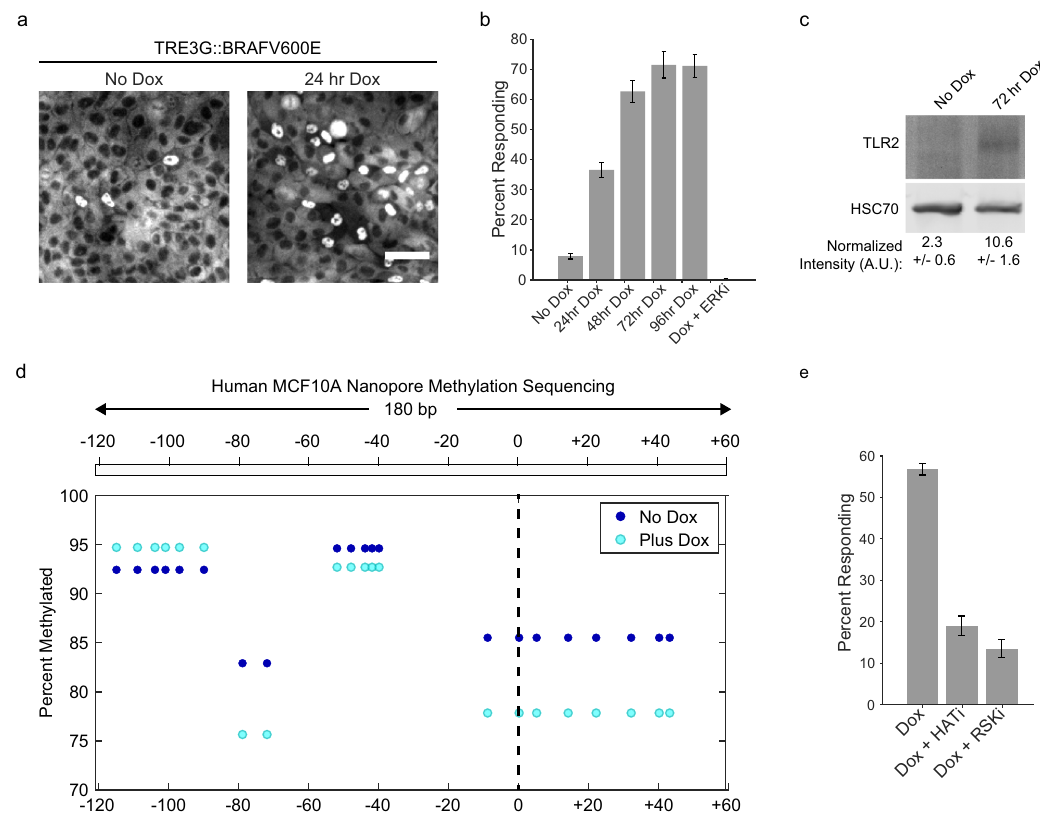
Fig. 6 Oncogene-induced epigenetic modi fi cations increase the responder percentage. a Clonal MCF10A cell line containing TRE3G::BRAF V600E was immunostained for p65 after 24 h of culture in the presence or absence of Doxycycline (2 µ g/ml) after Pam3CSK4 (1 µ g/ml) stimulation for 30 min. Representative images are shown. Scale bar, 50 μ m. b Monolayers treated with Pam3CSK4 (1 µ g/ml) only, or increasing duration of dox, or ERKi (5 μ M ulixertinib), prior to Pam3CSK4 treatment. Data represents three replicates. c TLR2 immunoblotting of BRAF V600E dox inducible cells as in panel b . HSC70 is loading control, relative amounts are reported with standard deviation representing two independent experiments. d TLR2 locus targeted nanopore methylation sequencing of genomic DNA isolated from human MCF10A cells with (Plus Dox, 96 h) or without (No Dox) BRAFV600E overexpression. e TRE3G::BRAF V600E monolayers were cultured with dox or inhibitors (HATi, A-485 (10 µ M) and RSKi, BI-D1870 (10 µ M)) and percent